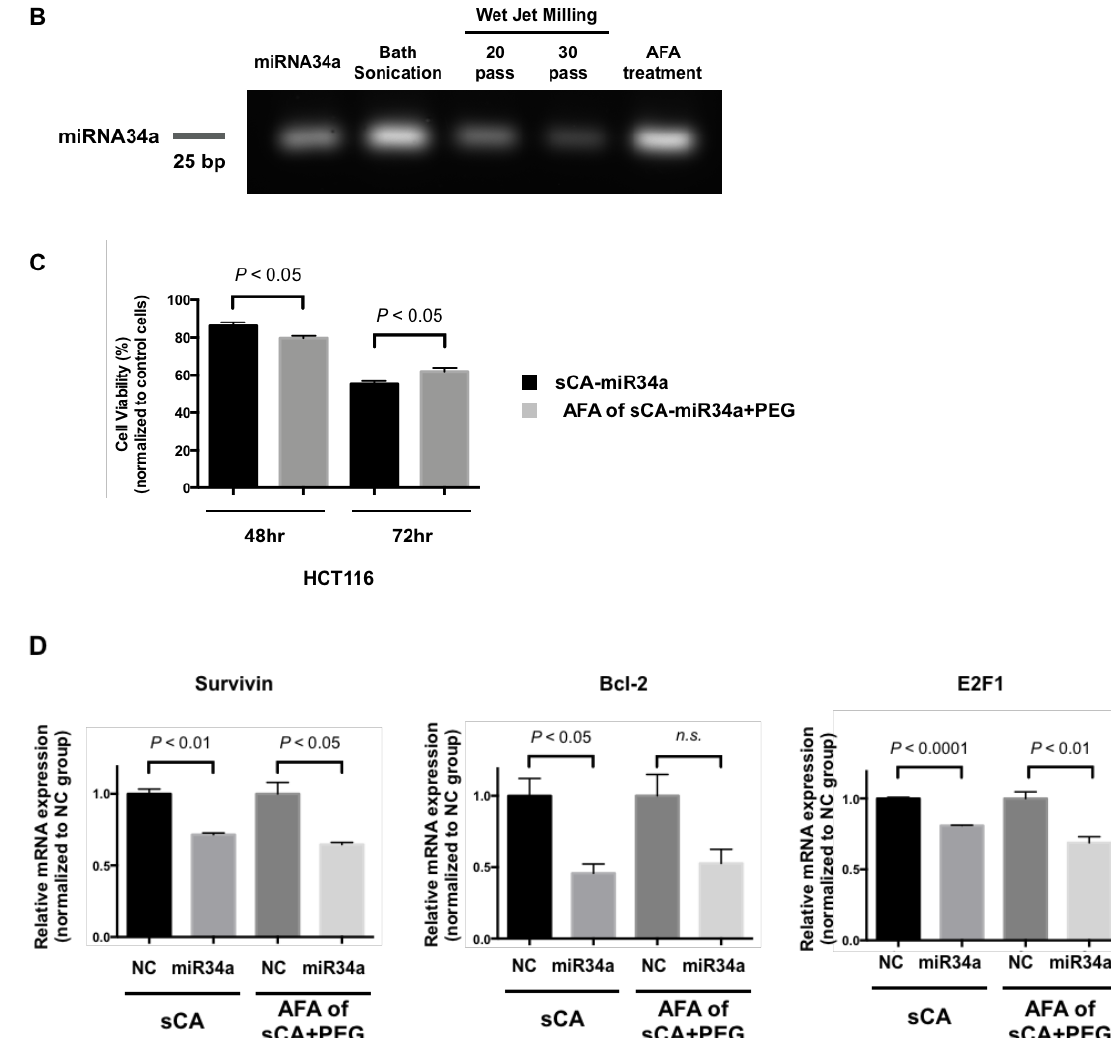
Figure 3. Pulverization of sCA-miRNA34a with PEG blending. ( A ) During sCA-miRNA34a production, meth- oxy-PEG-CO(CH 2 ) 2 COO-NHS (Mw 10,000) targeting the OH group of sCA ([Ca 10 (PO 4 ) 6 − X (CO 3 ) X (OH) 2 ]) was initially mixed with the constituents and three kinds of pulverization, bath sonication (38 kHz), wet jet-milling (30 pass), and AFA (1 MHz), performed after generation of the particles. The solution prepared for intravenous injection was directly (without dilution) analyzed by DLS, and both particle size distribution and autocorrelation function are shown for each sample. ( B ) Degradation of miRNA34a after the pulverization. ( C ) Proliferation assay of HCT116 human colon cancer cells at 48 and 72 h. ( D ) The mRNA expression of Survivin, Bcl-2, and E2F1 in HCT116 at 36 h after treatment. Data represent mean ± SEM (n = 4). p -values were obtained using the two-tailed t test.